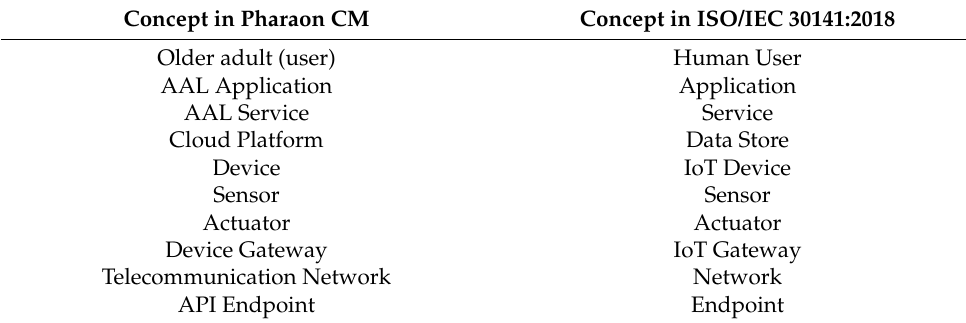
Table 2. Pharaon and AAL concepts mapped to concepts in ISO/IEC